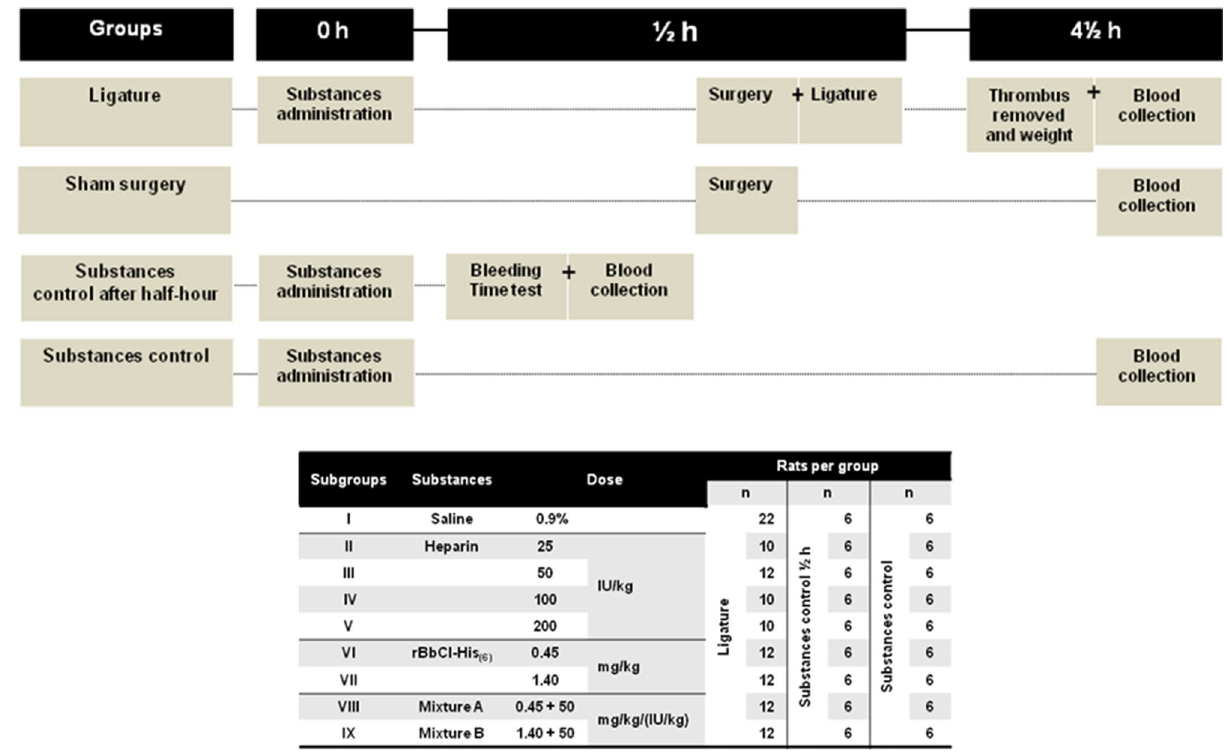
Figure 2. Timeline of the procedures realized indicating the experimental groups. Rats were allocated to 4 groups: Ligature group (treated with the studied substances, and submitted to IVC ligature), subdivided into 9 groups; Sham surgery (no treated, and submitted to surgery without VC ligature, n = 20); Substances control group after a half-hour (treated with the substances, non-operated, non-ligated), and substances control group after 4½ h treatment (treated with the studied substances, non-operated, non-ligated). The two groups were subdivided into 9